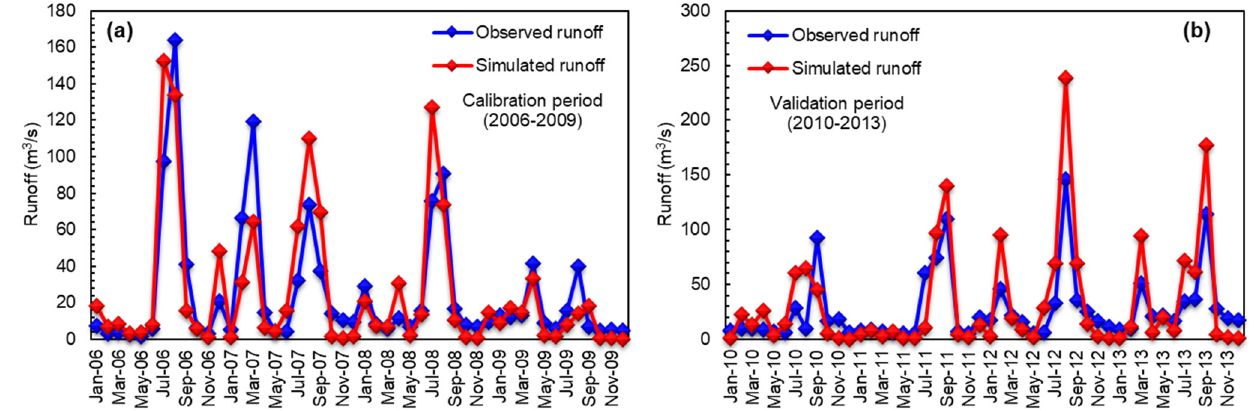
Figure 10. Profiles of simulated and observed runoff (monthly basis) at the SRB throughout ( a ) cal- ibration period, and ( b ) validation